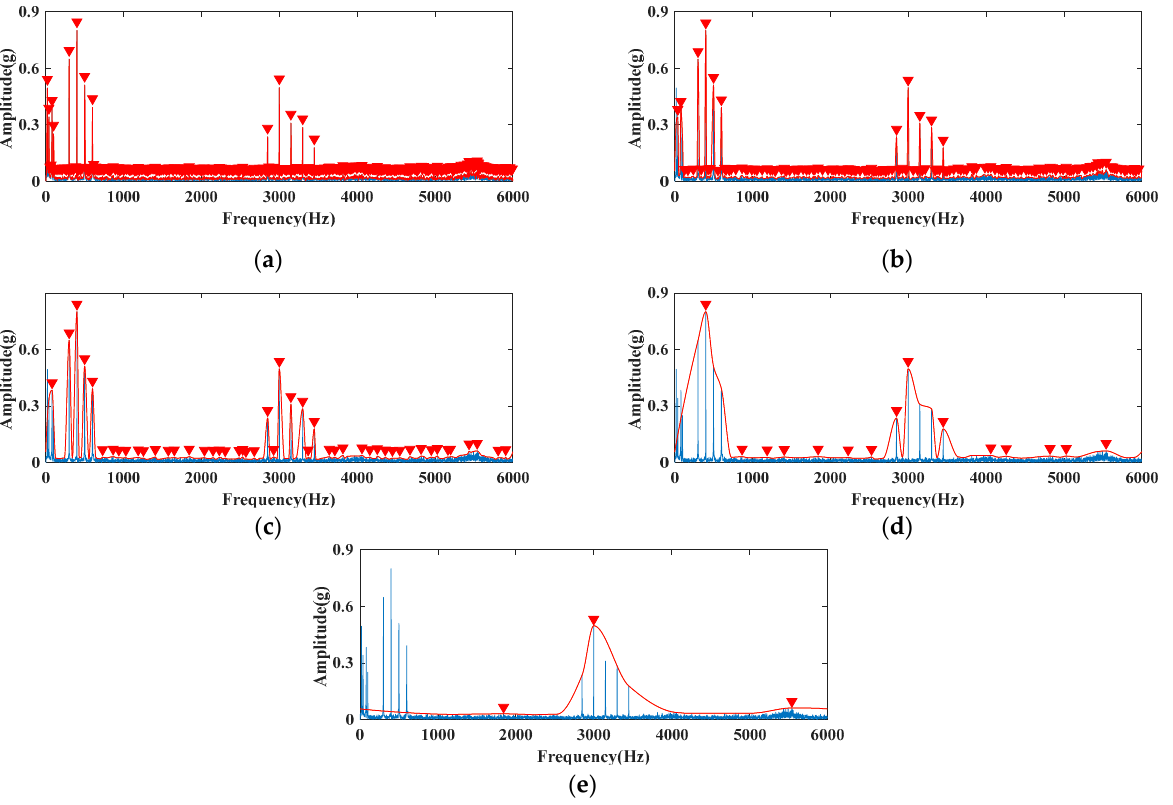
Figure 8. Envelope interpolation process: ( a ) 1st time execution; ( b ) 2nd time execution; ( c ) 3rd time execution; ( d ) 4th time execution; ( e ) 5th time